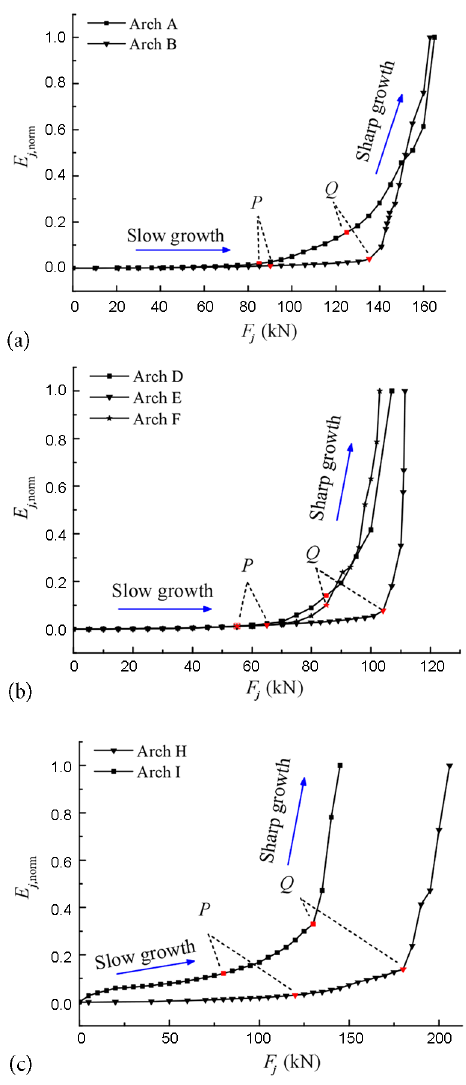
Figure 4. The E j ,norm - F j curves of experimental arches under different loading cases: a – loading case 1; b – loading case 2; c – loading case 3